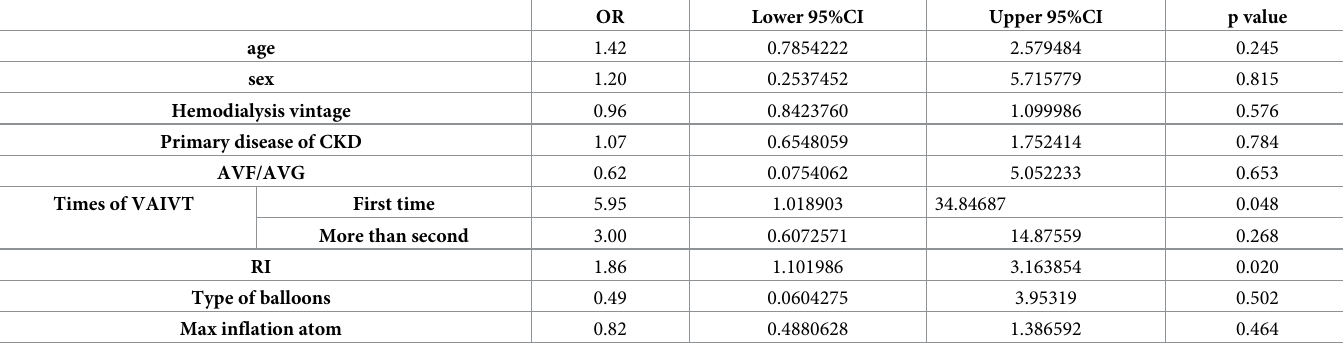
Table 3. Predictors of rupture based on multivariate logistic regression